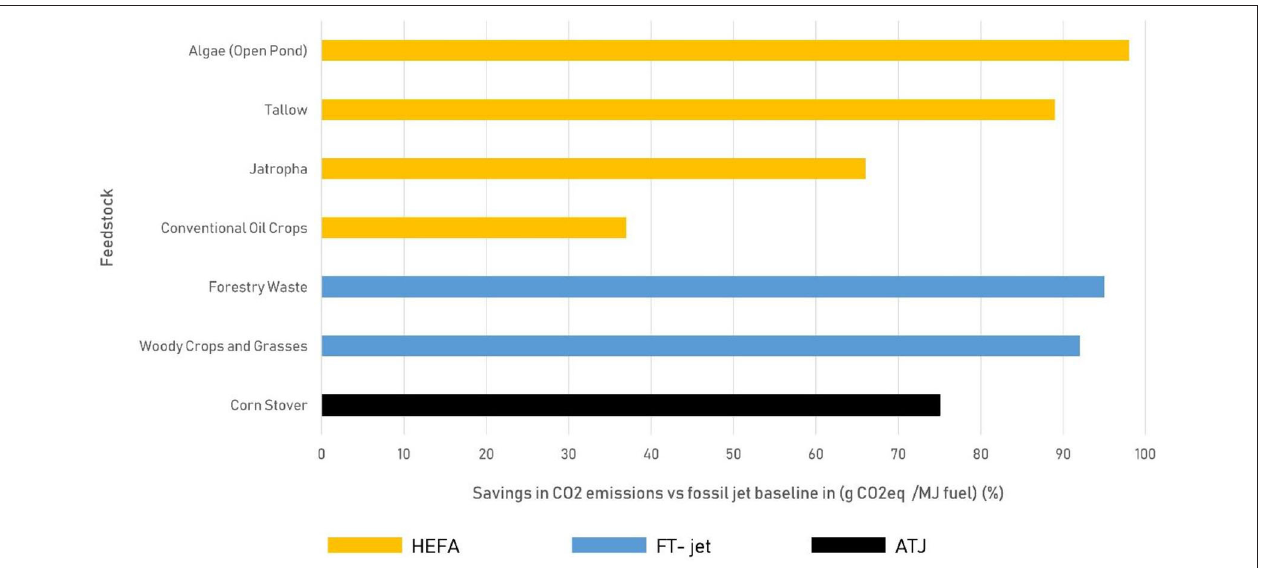
Nevertheless, WTW results show promising environmental sustainability of energy crops, waste biomass and algae as